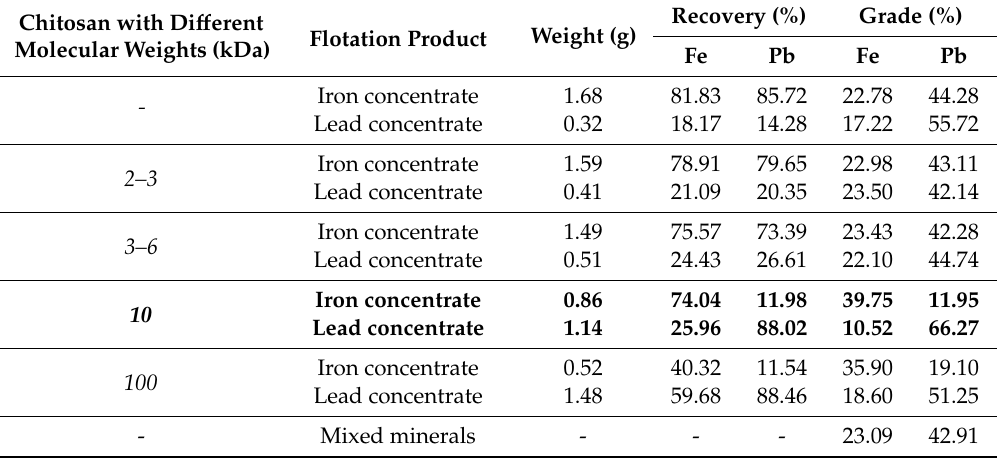
Table 1. The results of mixed-mineral flotation experiments using 400 g / t chitosan with different molecular weights as a depressant, 1600 g / t ethyl xanthate as a collector, and 100 g / t terpineol as a frother at pH 8.